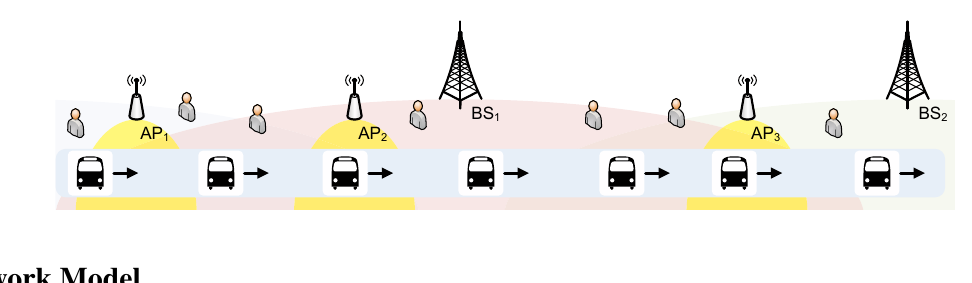
Figure 3. SCF relaying in a multiaccess